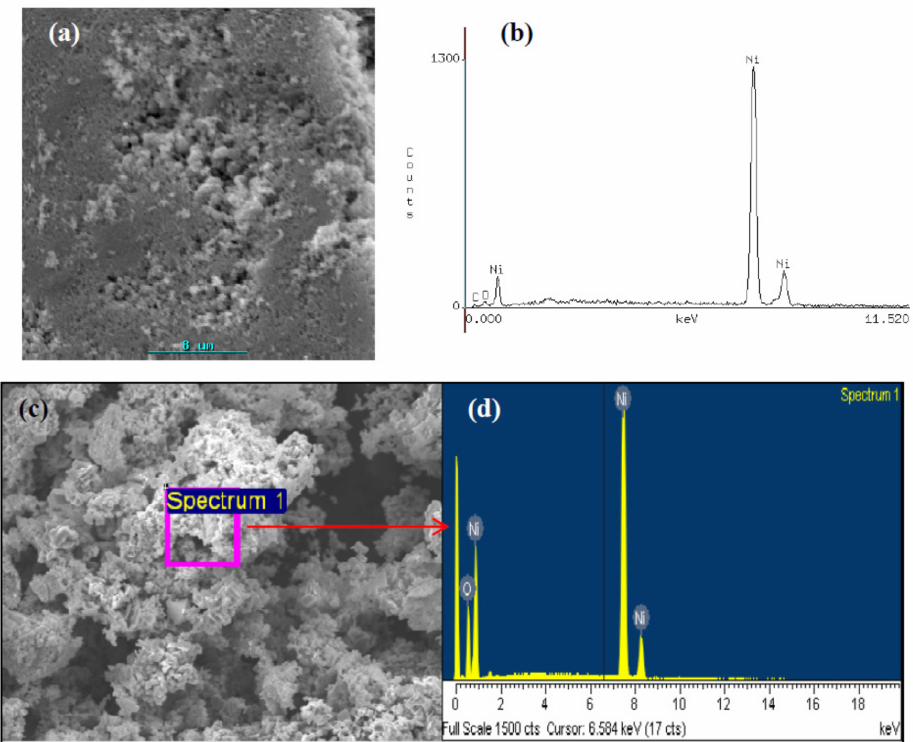
Figure 8. SEM image ( a ) and EDS analysis ( b ) from the pyrolytic product from 1:1 Chitosan · (NiCl 2 ) n precursor ( b ) and SEM image ( c ) and EDS analysis from ( d ) the 1:1 PS-co-4-PVP · (NiCl 2 ) n